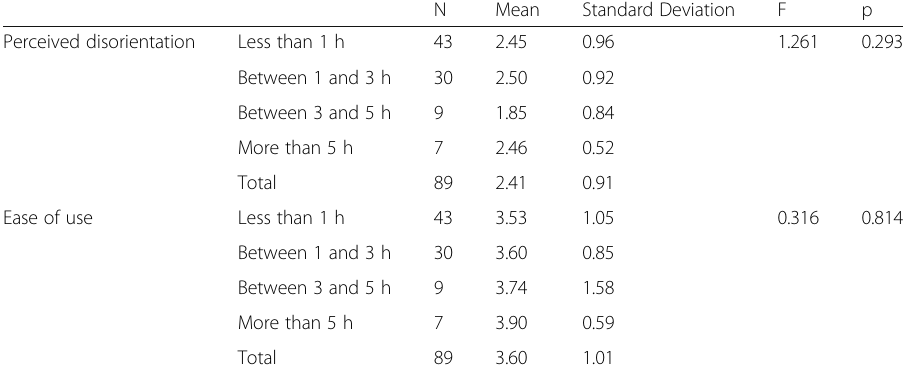
Interaction with OBCSS and navigation processes Navigation paths